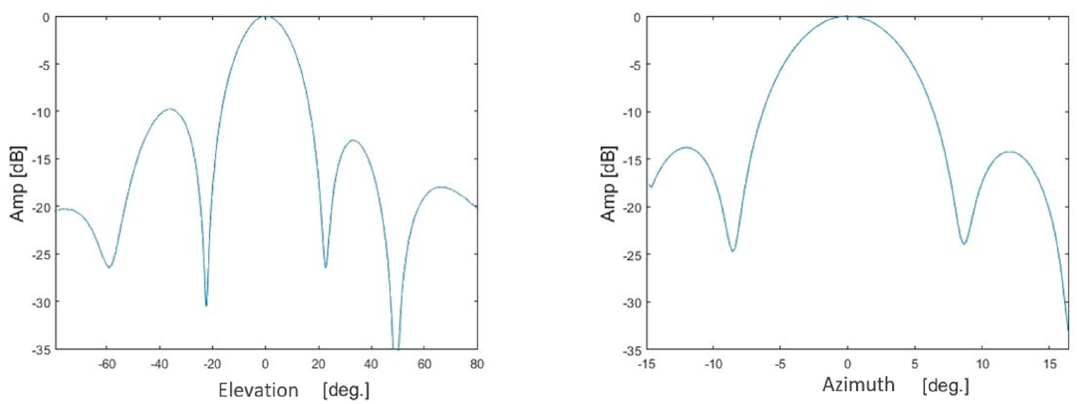
Figure 1. Elevation ( left ) and azimuth ( right ) normalized radiation patterns of one of the three radar antennas of the AXIS (Airborne X-band Interferometric Synthetic Aperture Radar (SAR)) system.